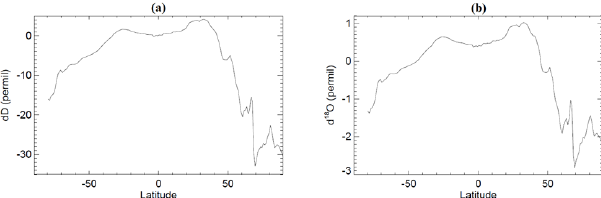
Fig. 1. (a) The global zonal-mean HDO isotopic composition of sea surface water ( δ D) from a MPI-OM present-day climate control simulation. (b) The same as (a) , but for H 18